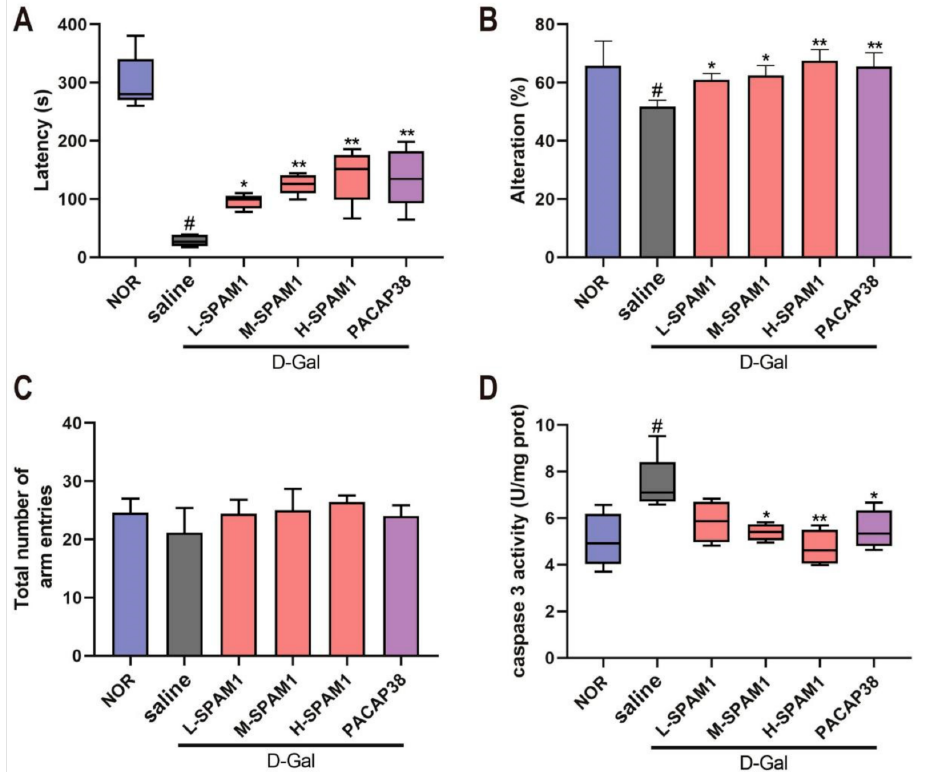
Figure 6. Effect of SPAM1 and PACAP38 on D-Gal-induced memory and cognitive impairment. The mouse D-Gal aging model treated with L-SMAP1 (10 µ mol/kg/day), M-SMAP1 (40 µ mol/kg/day, H-SMAP1 (100 µ mol/kg/day) and PACAP3 (100 nmol/kg/day), respectively, was submitted to passive avoidance experiment and Y-maze test. ( A ) The latency in passive avoidance experiments demonstrated that SPAM1 (L, M and H) and PACAP38 ameliorated the memory impairment by D-gal significantly. Spontaneous alternation ( B ) and the number of total arm entries ( C ) from Y-maze test are shown along with the caspase 3 activity in the mice brain ( D ). #, p < 0.05, D-Gal group vs. control group (NOR); *, p < 0.05, vs. D-Gal group; **, p < 0.01, vs. D-Gal group. Data are presented as the mean ± SEM, n =